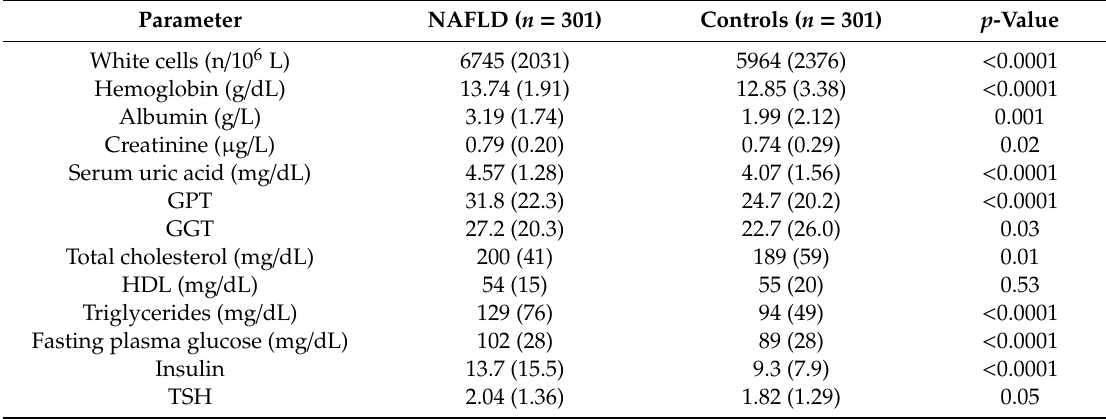
Table 2. Bio- humoral parameters related to the presence or not of hepatic steatosis.